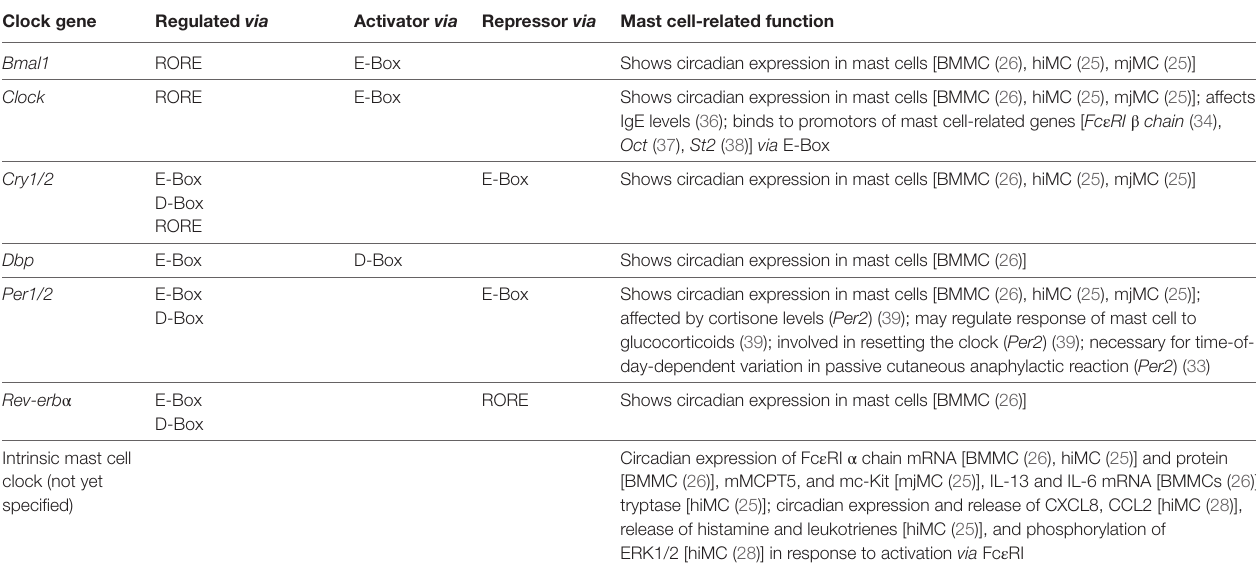
TAbLe 1 | Clock genes analyzed in mast